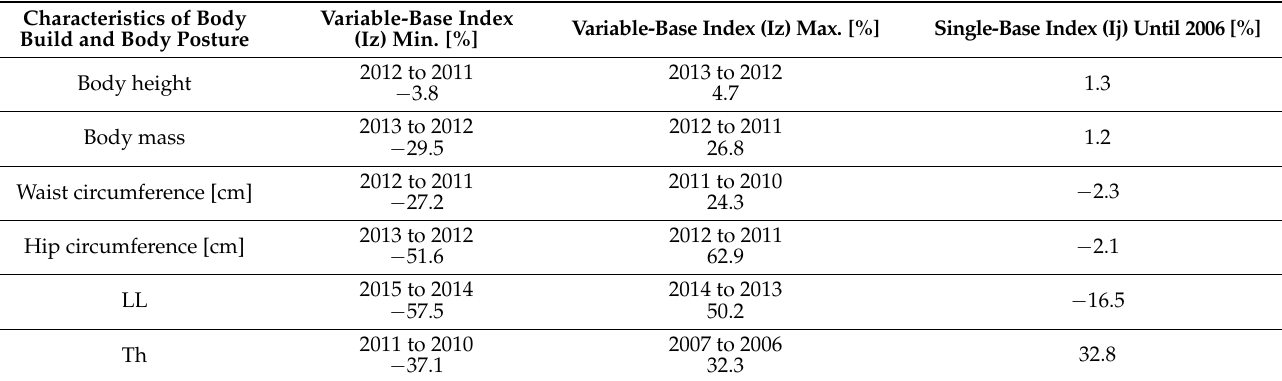
Table 5. Dynamics of the variability of time series for the characteristics of body build and posture in men [%] in terms of single-base indices (Ij) and variable-base indices (Iz) between 2006 and 2016. Characteristics of Body Variable-Base Index Variable-Base Index (Iz) Max. [%] Single-Base Index (Ij) Until 2006 [%] Build and Body Posture (Iz) Min. [%]